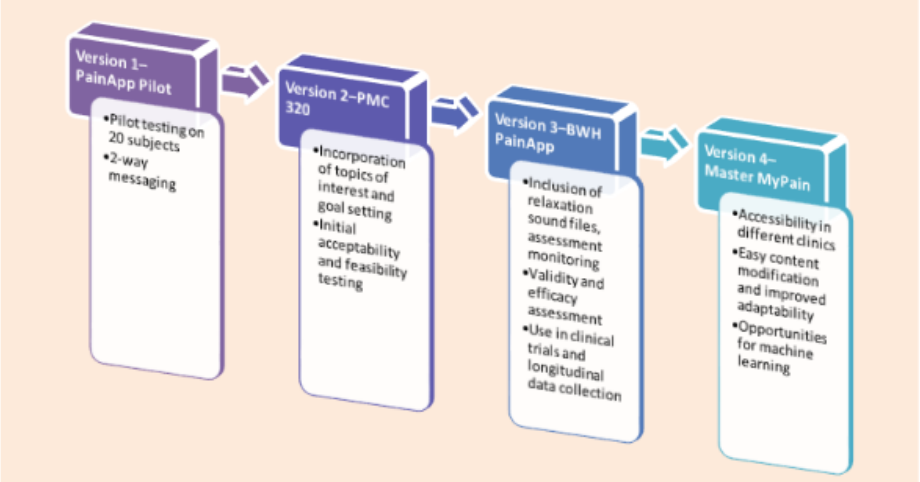
Figure 1. Key development highlights from each version of the pain app. BWH: Brigham and Women's Hospital; PMC: Pain Management